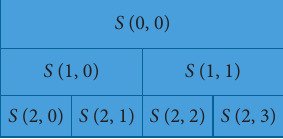
Figure 1: The SLEX